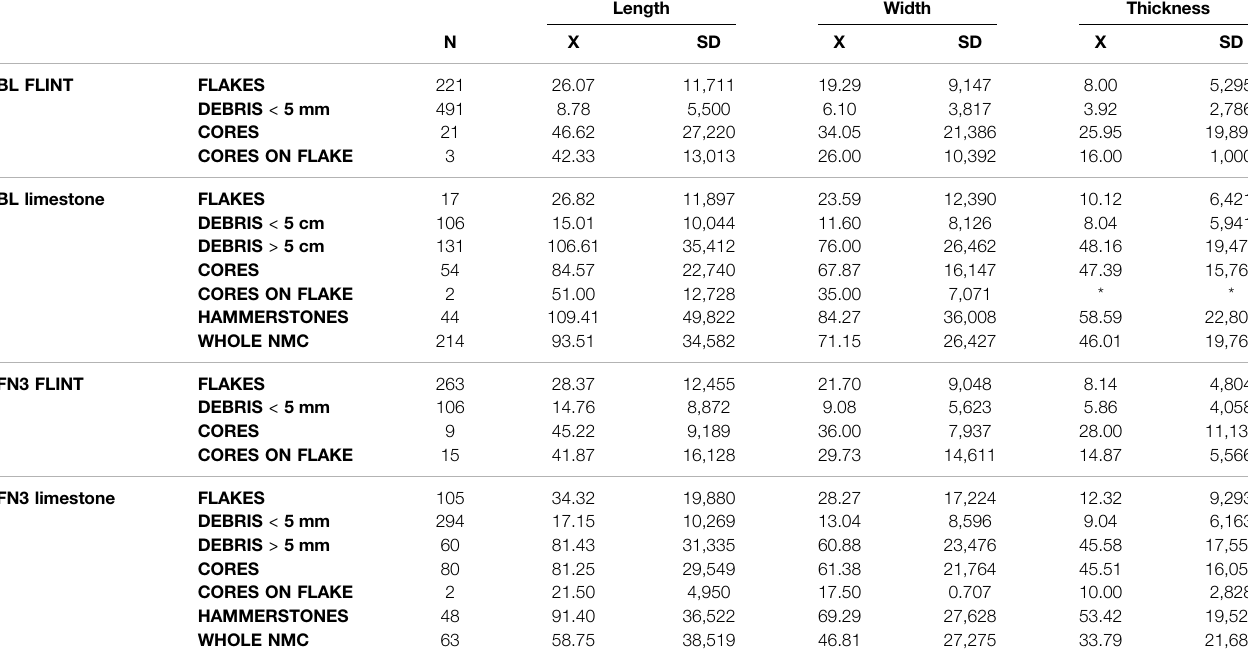
TABLE4| DimensionalfeaturesofthedifferenttoolcategoriesfromBarrancoLeónandFuenteNueva3inaccordancetothetwomainrocktypes.Thicknesswasaconstant for cores on fl akes in limestone from BL.